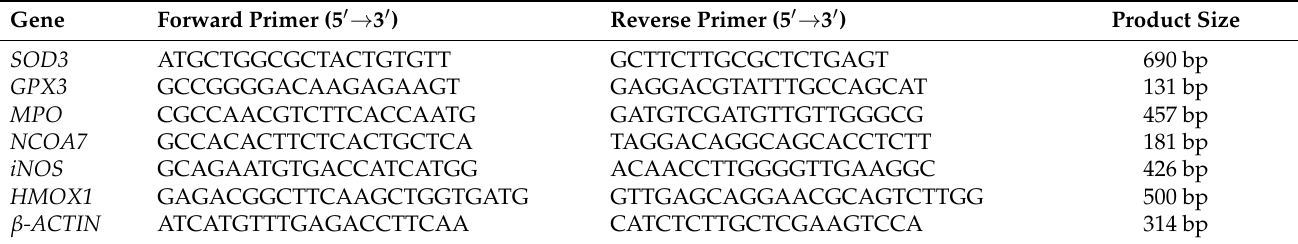
Table 1. Primers for reverse transcription polymerase chain